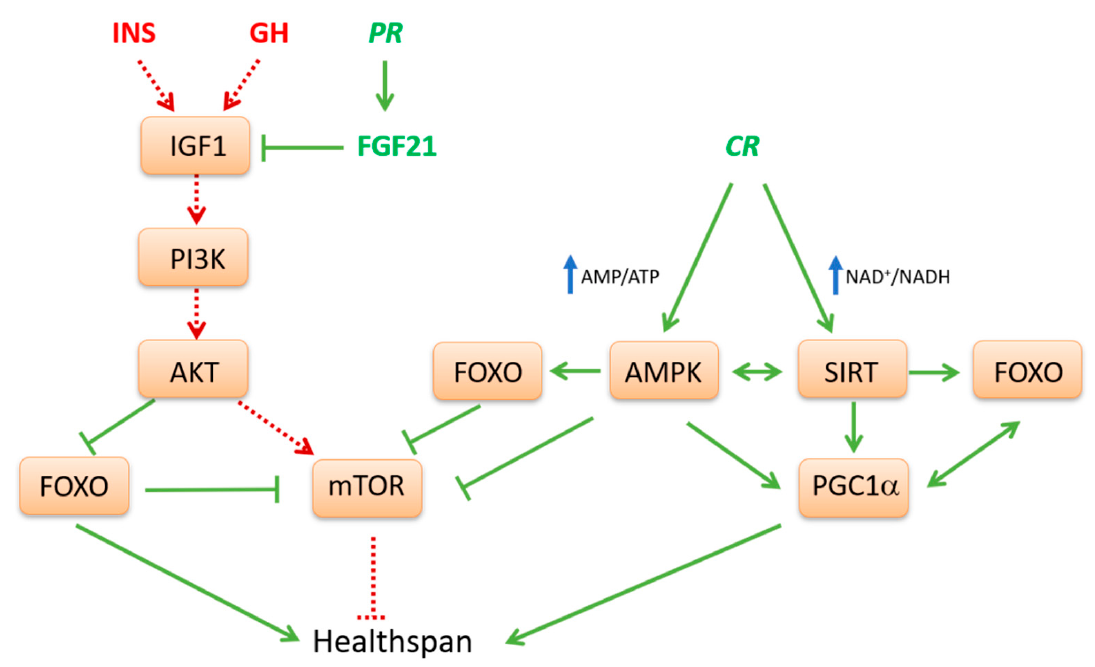
Figure 1. Interplay between nutrient-sensing pathways potentially a ff ecting health span. A complex crosstalk exists between nutrient and energy-sensing pathways in mammals. Caloric restriction (CR), that is a 25–30% reduction of caloric intake without malnutrition, as well as other dietary restriction (DR) interventions such as protein restriction (PR) or low protein / carbohydrate diets represent conditions that downregulate the insulin-like growth factor 1 (IGF1) mediated pathway. A reduced signaling of this pathway leads to a decrease of AKT, which causes the inhibition of mammalian target of rapamycin (mTOR) and activation of forkhead box O transcription factor (FOXO) which, in turn, suppresses mTOR. Reciprocal modulation of mTOR and FOXO induced by CR correlates with reduced global protein synthesis and decreased cell growth and proliferation. In PR conditions, low levels of essential dietary amino acids, particularly of methionine, stimulates the expression of fibroblast growth factor 21 (FGF21), a main inhibitor of IGF1 signaling. Through these mechanisms, DR orchestrates a program of genes involved in protein homeostasis and stress resistance that positively a ff ects health span. Under conditions of CR, increased cellular AMP / ATP and NAD + / NADH ratios cause activation of AMP-activated protein kinase (AMPK) and sirtuins (SIRTs), respectively. AMPK, a critical cellular energy sensor, inhibits mTOR and contributes to stimulate SIRTs, including SIRT1 and SIRT3. In turn SIRTs, through a positive loop, further favor activation of AMPK itself. Both AMPK and SIRTs activate FOXO and peroxisome proliferator-activated receptor gamma coactivator 1 α (PGC1 α ) through phosphorylation and deacetylation, respectively. PGC1 α coactivates FOXO thus favoring the expression of key antioxidant enzymes as well as pathways involved in autophagy and mitophagy. Moreover, PGC1 α induces the transcription of many important genes involved in mitochondrial biogenesis, complete fatty acid oxidation and stress resistance pathways. Therefore AMPK, SIRTs, FOXO and PGC1 α can engage in a positive feedback loop, thus connecting these sensors into a unified response which may improve health span. This simplified model does not account for macronutrient-specific responses or tissue-specific nutrient detection and it does not distinguish between di ff erent tissues when summarizing downstream signaling e ff